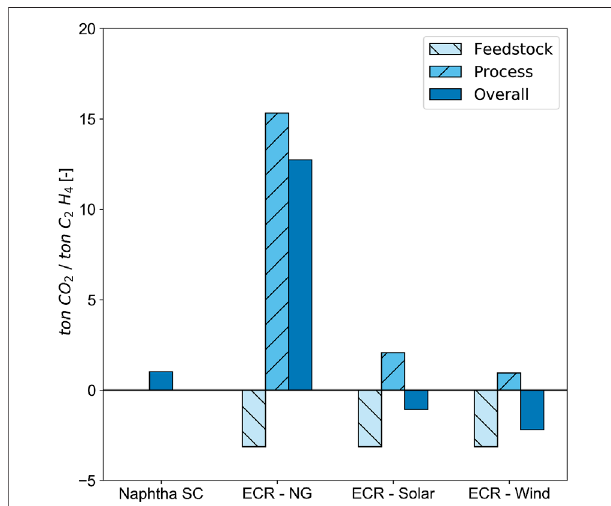
FIGURE 9 | CO 2 emissions per metric ton of ethylene produced: Comparison between steam cracking (SC) of naphtha and the electrochemicalreduction(ECR)ofCO 2 usingelectricityfromnaturalgas(NG), solar and wind energy. For the ECR process, both the CO 2 used as feedstock as well as the CO 2 emitted during the complete process is